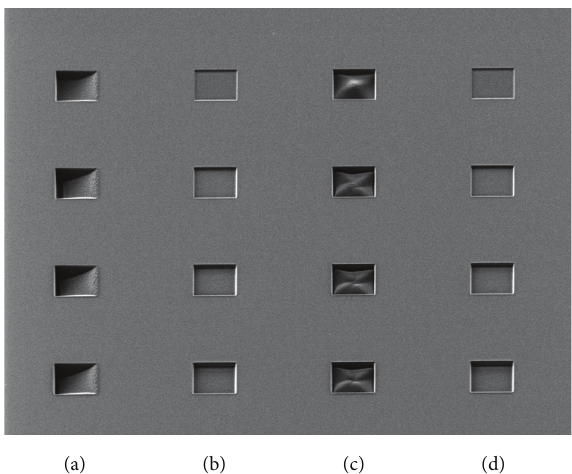
Figure 2: Secondary electron image scanned with gallium ions at 45 degree sample tilt of 1.5 𝜇 m size square-shaped patterns milled in single- crystal silicon showcase different filling algorithms and timing. Meandering vertical lines filling from right to left was used in ((a) and (b)), and filling with concentric annular frames from center outward was used in ((c) and (d)). The full dose was delivered in one scan in (a) and (c), while the dose was distributed to 200 repetitions in (b) and (d). The ion dose is increasing downward along the squares by the same amount in all columns ((a)–(d)).